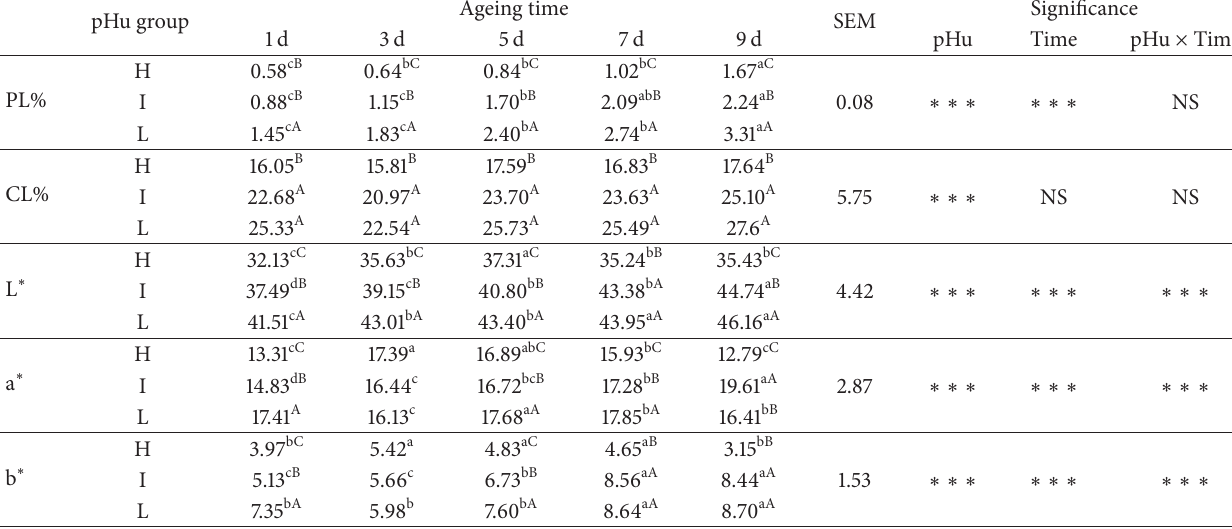
Table 1: Effect of ultimate pH (pHu) and ageing time on purge loss (PL), cooking loss (CL), and meat color of M. Longissimus dorsi in Chinese Yellow crossbreed cattle (means ±